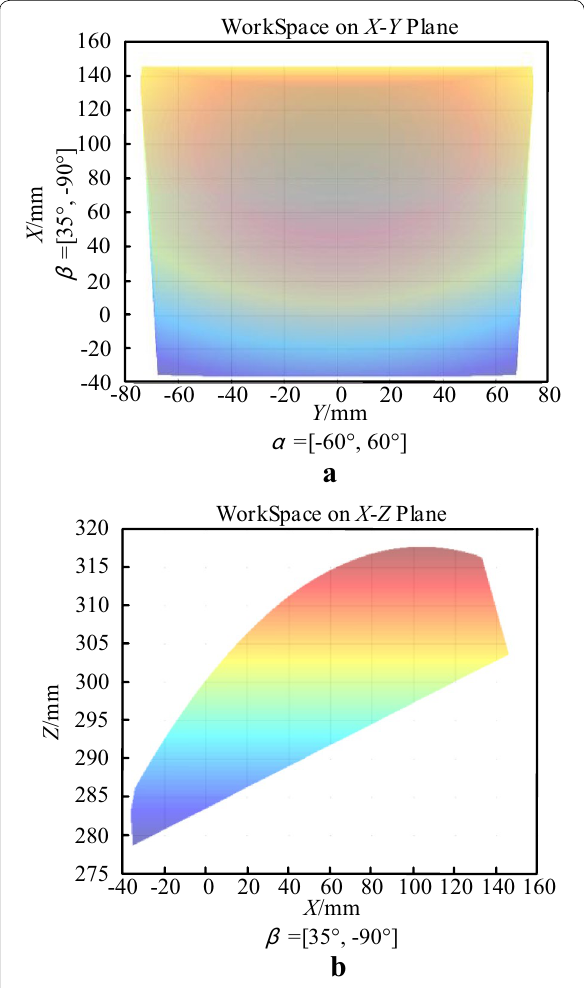
Figure 8 Workspace of the 2-UPR/URR Parallel Mechanism: a spatial location on the X - Y plane; b spatial location on the X - Z